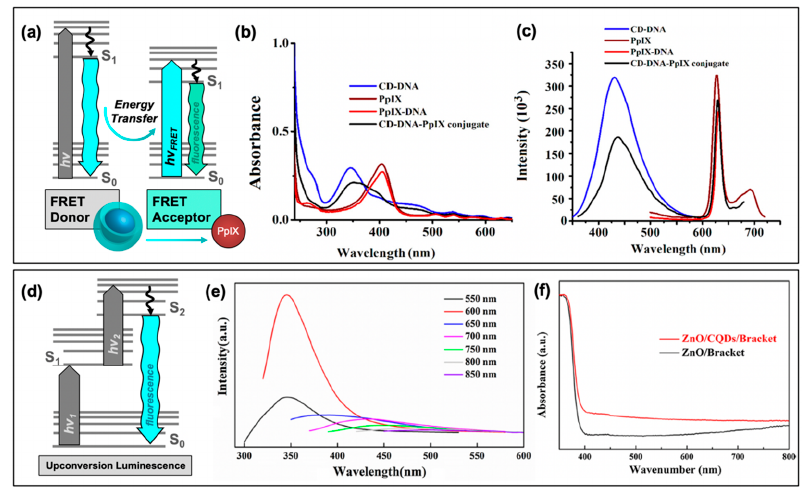
Figure 12. Carbon nanodots in photodynamic hybrid systems, including ( a – c ) fluorescence